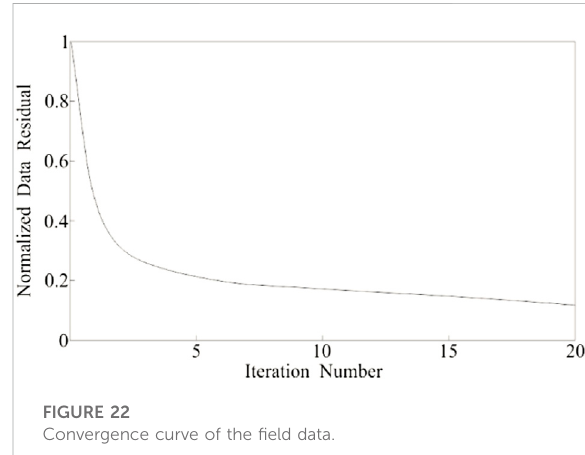
FIGURE 22 Convergence curve of the fi eld